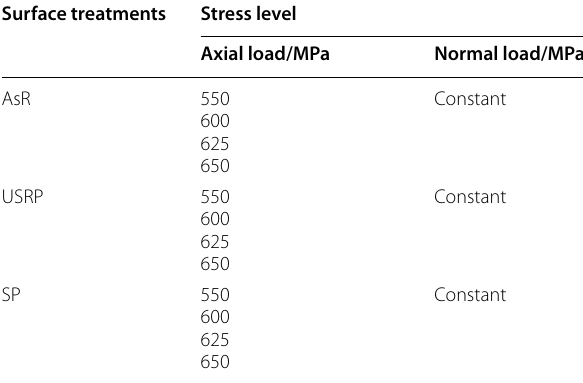
Table 5 Fretting fatigue experiment conditions Surface treatments